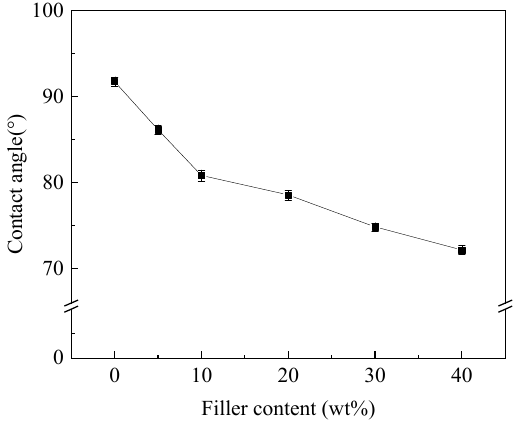
Figure 3. Static water contact angles of the HF-Ti 3 C 2 T x /epoxy composites.